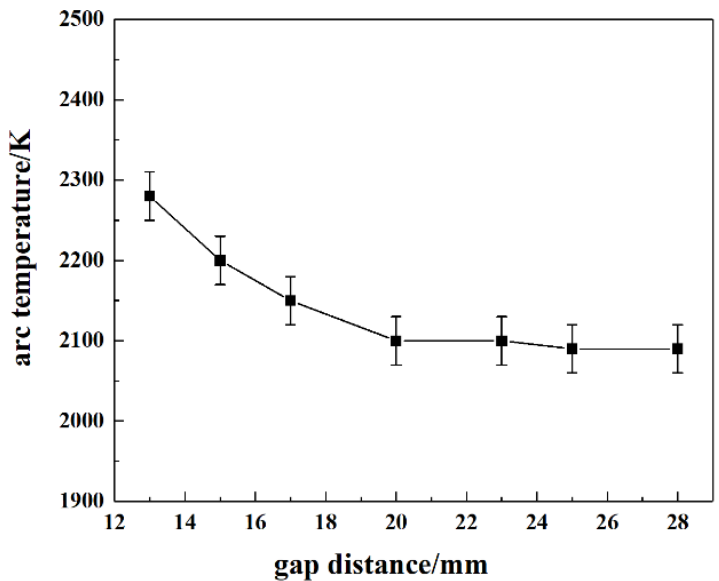
Figure 9. The gas temperature of the arc discharge as a function of the gap distance between the tips of the electrodes.